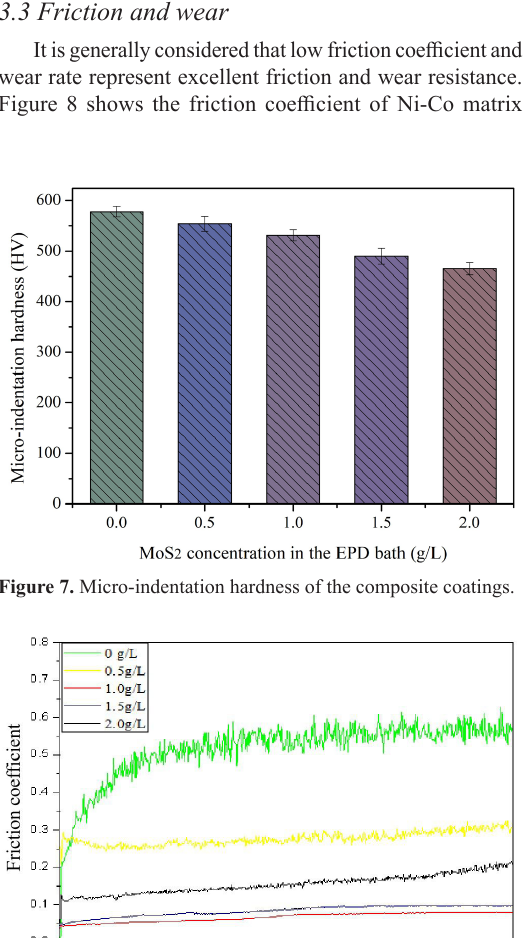
Figure 8. The effect of MoS the composite coating.